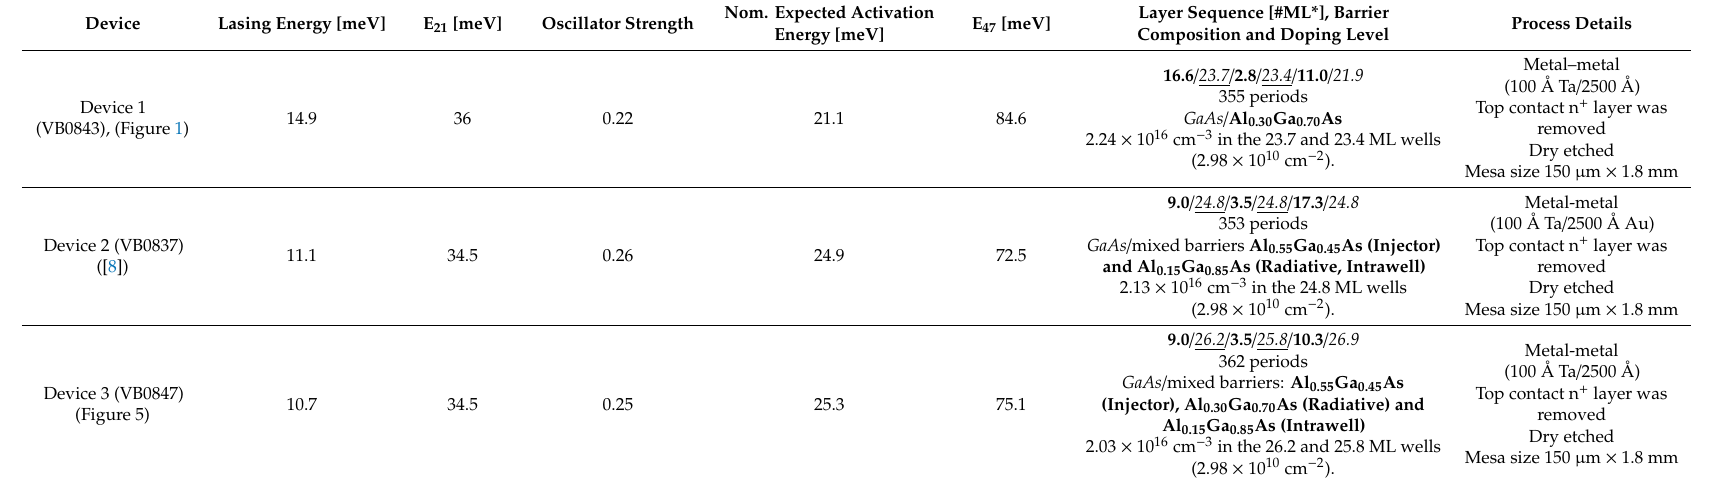
Table 1. Main nominal design parameters and device data.